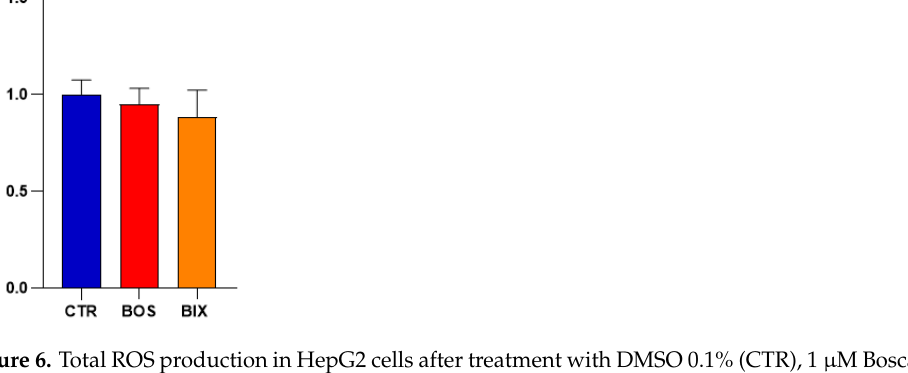
Figure 5. Level of mitochondrial superoxide in control (DMSO 0.1%) and SDHIs-exposed human cells (1 µM for 2 h). Signal intensity of Mito-TEMPO • at time point 15 min (normalized to control). Top row: Boscalid-treated cells. A : HepG2 liver cells, B : PBMCs, C : BJ-fibroblasts. Bottom row: Bixafen-treated cells. D : HepG2 liver cells, E : PBMCs, F : BJ-fibroblasts. Bars represent mean ± SEM. N = 3, (*): p < 0.05, (**): p < 0.01.